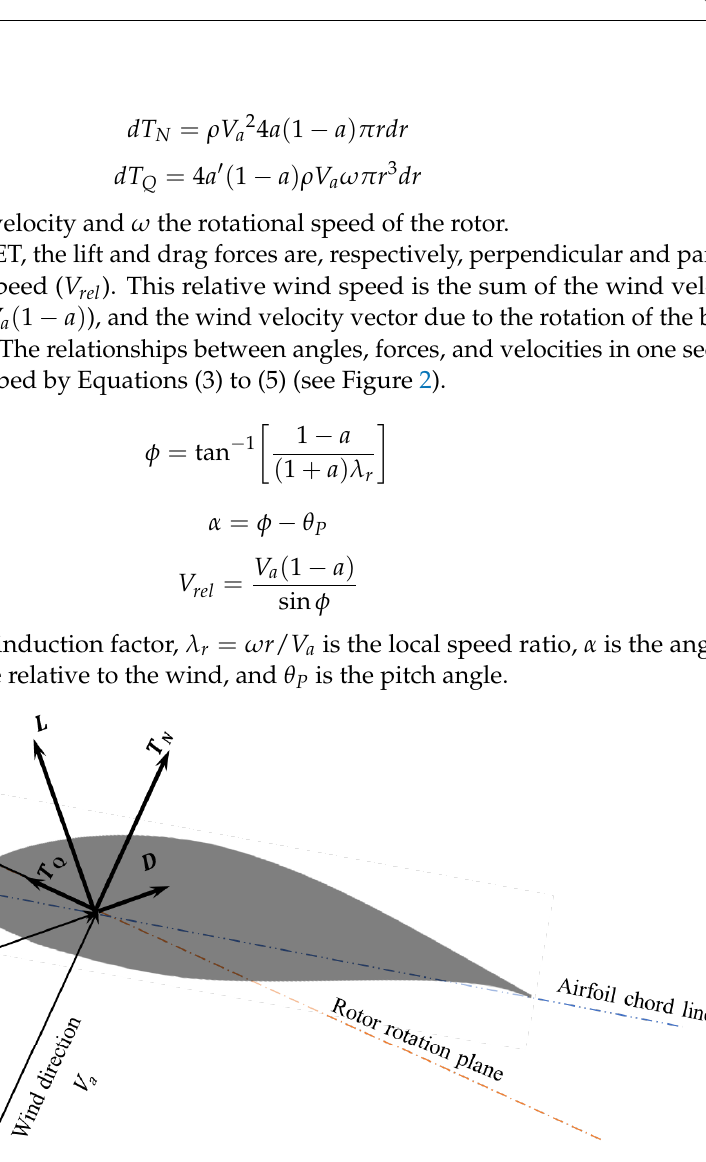
Figure 2. Blade geometry for analysis of a HAWT; for the definition of variables, see text. @Fahed